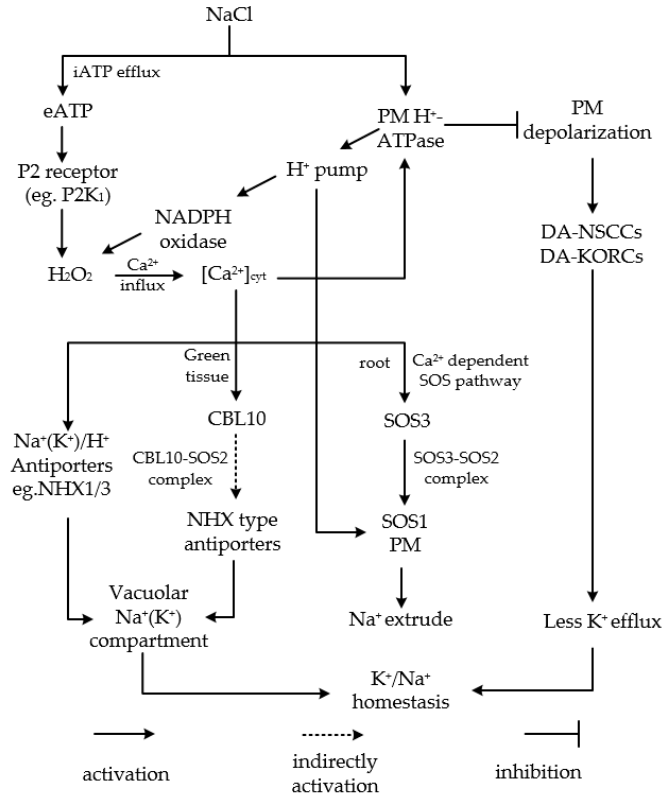
Figure 1. Schematic model showing multiple signaling networks active in Populus in response to NaCl stress. NaCl induces the efflux of intracellular ATP (iATP) and an increase in extracellular ATP (eATP), which is sensed by P2K 1 in the plasma membrane (PM) and leads to the induction of H 2 O 2 production. This stimulates the movement of Ca 2+ into the cells via Ca 2+ -permeable channels. The elevated cytosolic Ca 2+ concentration initiates the SOS pathway by stimulating Na + /H + antiporters, such as SOS1, localized in the PM to extrude Na + , or activates CBL10, forming the CBL10–SOS2 complex, which may indirectly target the NHX type antiporters to the tonoplast to compartmentalize Na + into vacuoles in green tissues. The elevated cytosolic Ca 2+ also stimulates tonoplast-localized NHX1/3 to accumulate Na + (K + ) into vacuoles. Besides, the elevated cytosolic Ca 2+ increases H + -ATPase activity in the PM, which activates a H + pump to supply a proton gradient for the Na + /H + antiporters, stimulating the extrusion of Na + . A proton gradient supplied by the H + pump contributes to the activation of NADPH oxidases, which leads to H 2 O 2 production. H + -ATPases can also inhibit the efflux of K + by further polarizing the PM. All these signaling components help to maintain K + /Na + homeostasis in Populus cells.